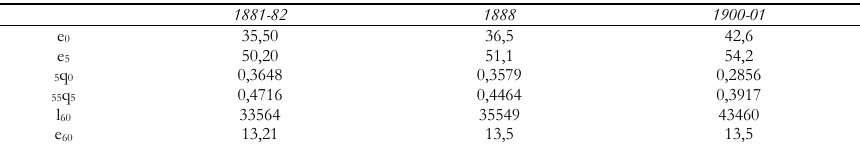
Mortality and survival indicators in Italy (both sexes), 1881-1901 1881-82